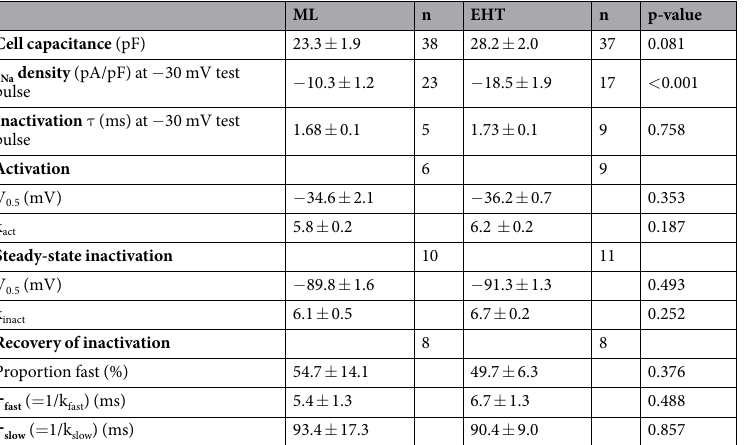
Table 1. Biophysical parameters of ML and EHT cultured hiPSC-CM. HiPSC-CM: human induced pluripotent stem cell-derived cardiomyocytes; n: number of cardiomyocytes; I Na density measured at − 30 mV from − 110 mV holding potential; V 0.5 : voltage of half-maximal (in)activation; k: slope factor of voltage-dependence of (in) activation; τ fast / τ slow : fast and slow time constants of recovery from inactivation. Values are mean ±